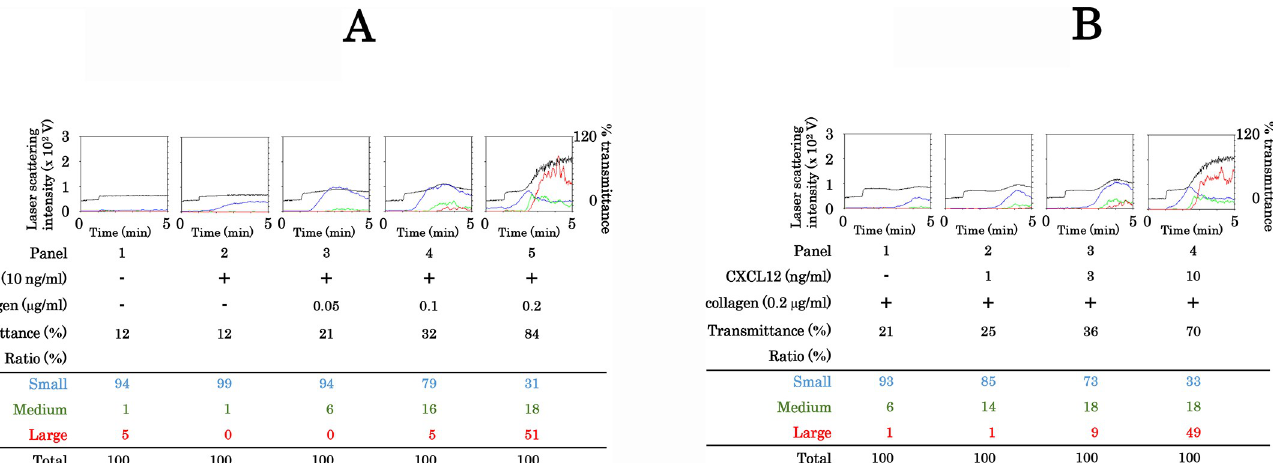
PLOS ONE | https://doi.org/10.1371/journal.pone.0241139 October 29,